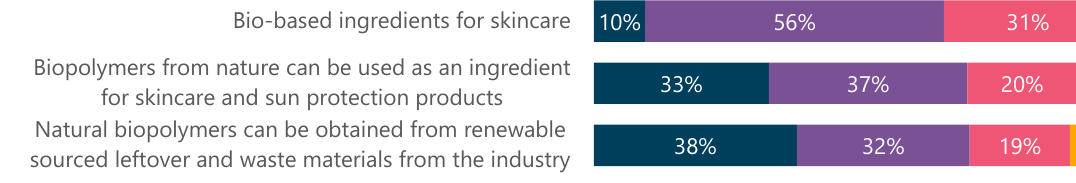
Figure 5. Self-assessed familiarity with bio-based ingredients.